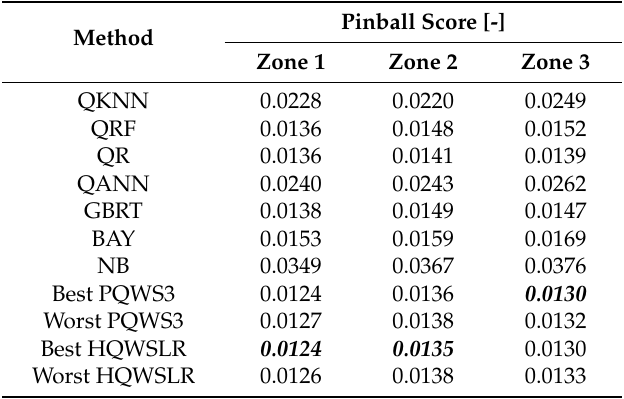
Figure 6. Pinball Score values of combined forecasts for the zone 2: ( a ) the Pure Quantile Weighted Sum (PQWS)2, PQWS3, Hourly Quantile Weighted Sum (HQWS)2, and HQWS3 strategies; ( b ) Pure Constrained Quantile Weighted Sum (PCQWS)2, PCQWS3, Hourly Constrained Quantile Weighted Sum (HCQWS)2, HCQWS3 strategies; ( c ) Pure Quantile Weighted Sum with Least Absolute Shrinkage and Selection Operator (LASSO) Regularization (PQWSLR), Hourly Quantile Weighted Sum with LASSO Regularization (HQWSLR), Pure Quantile Weighted Sum with Ridge Regularization (PQWSRR), Hourly Quantile Weighted Sum with Ridge Regularization (HQWSRR) strategies. Table 3. Pinball Score values averaged over the tasks 11–15. Bold values highlight the best results for each